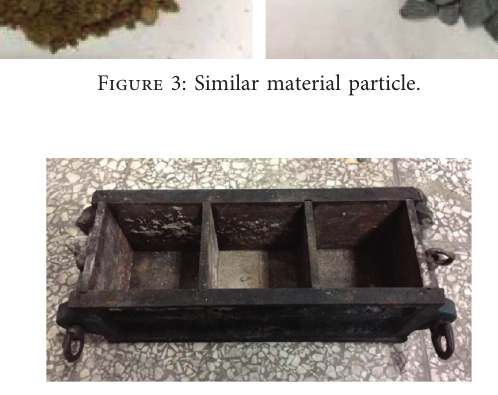
Figure 4: The mold for proportioning experiment. Table 1: Physical and mechanical parameters of coal and rock mass.